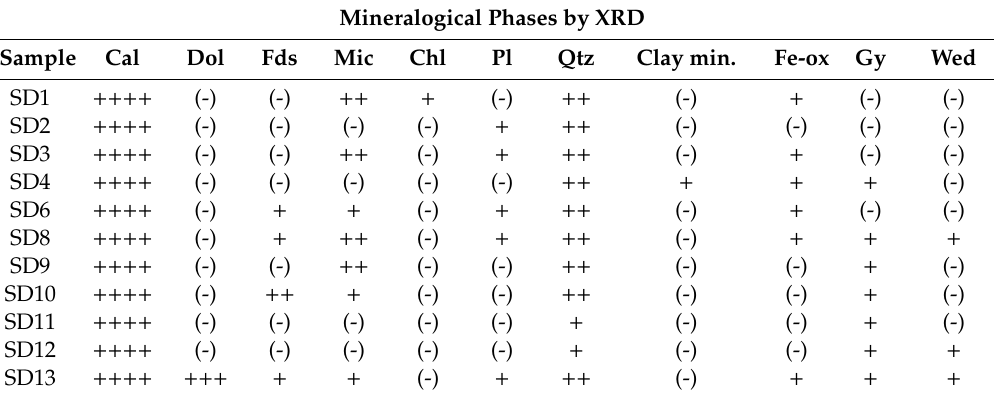
Figure 4. Representative photomicrographs by POM showing some textural features of biomicrites samples ( A , B ) and biosparites ( C , D ). Table 3. Main mineralogical phases of investigated samples as obtained by XRD. Notes: Cal = calcite; Dol = dolomite; Qtz = quartz; Fds = feldspars; Pl = plagioclase; Gy = gypsum; Mic = micas; Chl = chlorite; Clay min. = clay minerals. Wed = weddellite; Fe.ox = iron oxides; ++++ = very abundant; +++ = abundant, ++ = moderate; + = scarce; (-) = absent.